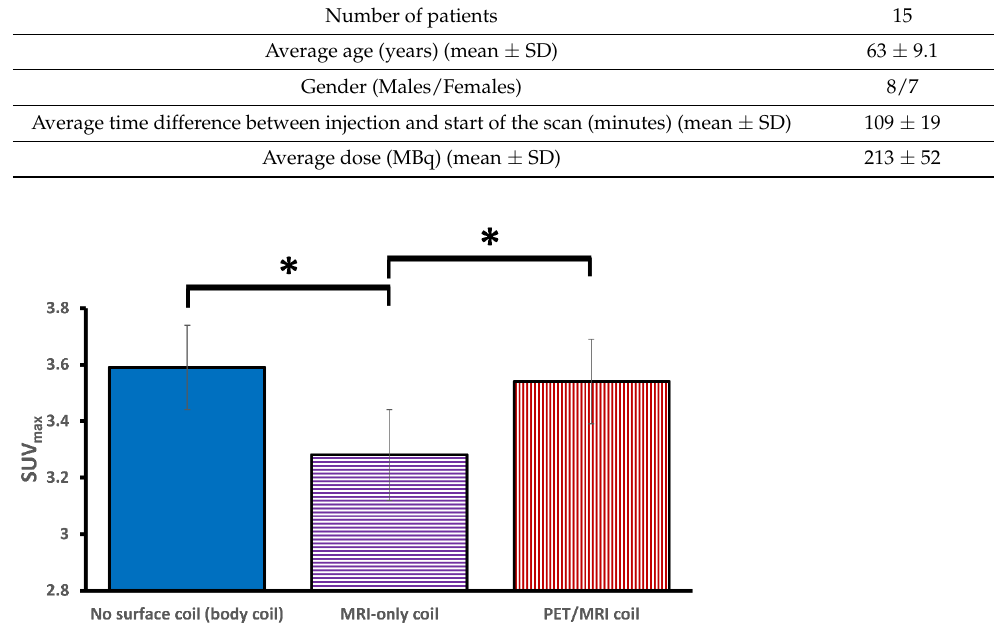
Figure 5. Bar chart showing the mean SUV max values for the three configurations. The error bars represent the standard error. PET/MRI and no surface coil configuration showed significantly higher SUV max values as compared to the MRI-only coil. No significant difference was observed between PET/MRI and no surface coil configuration. The asterisks ("*”) indicate a significant difference in SUV max ( p <